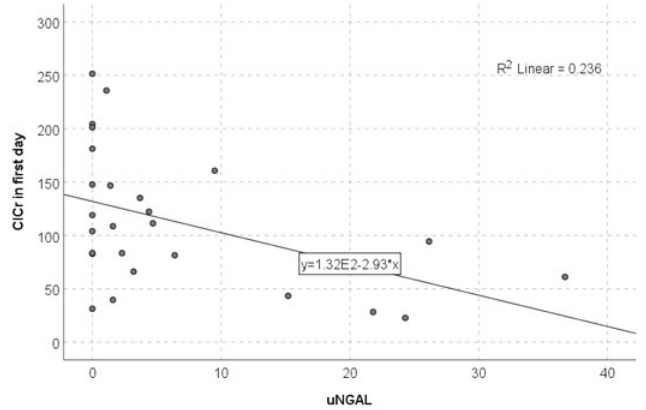
Figure 1. The CrCl–uNGAL relationship on day 1 of PICU admission.